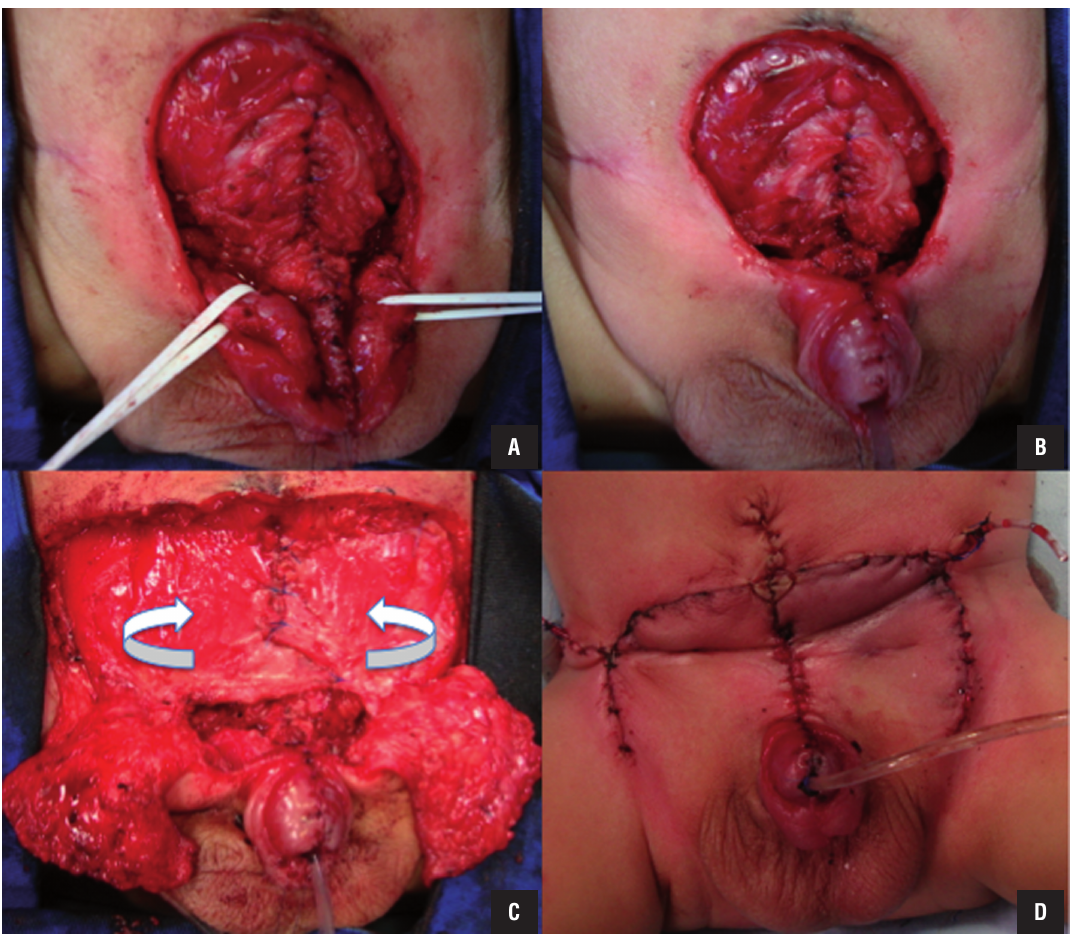
Figure 1 – Steps of one-stage reconstruction: A) Closure of the bladder and tubularized urethra; B) Penile